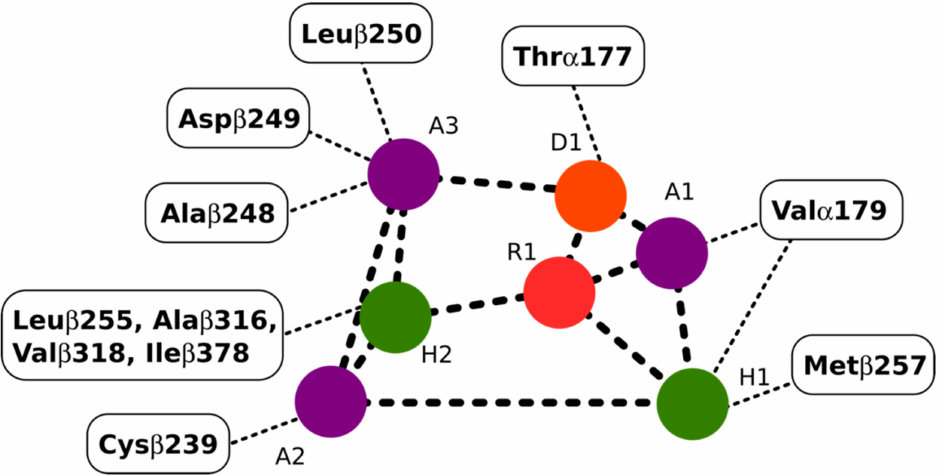
Figure 3. Interactions between the pharmacophoric points and the tubulin structure. Seven pharma- cophoric points: three hydrogen bond acceptors (A1, A2, and A3) in purple dots, one hydrogen bond donor (D1) in an orange dot, two hydrophobic centers (H1 and H2) in green dots, and one planar group (R1) in a red dot. Figure 3 was designed based on the information provided in the source